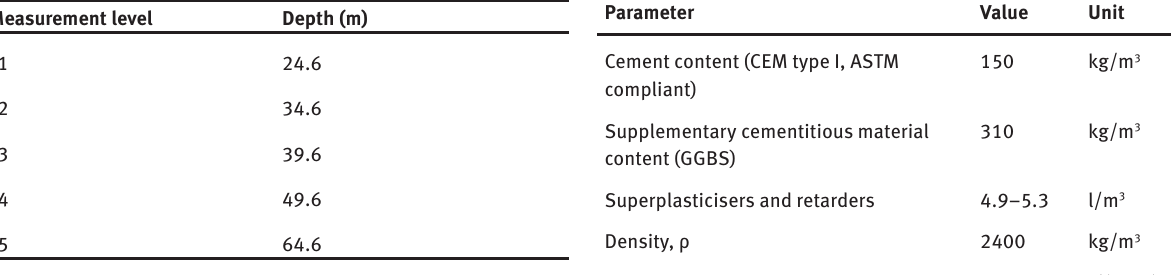
Table 3: Concrete